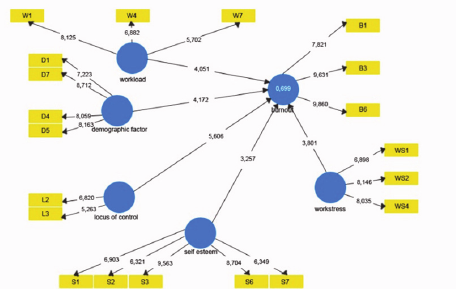
Fig. 2. The Correlation of Variables Source: From data processing